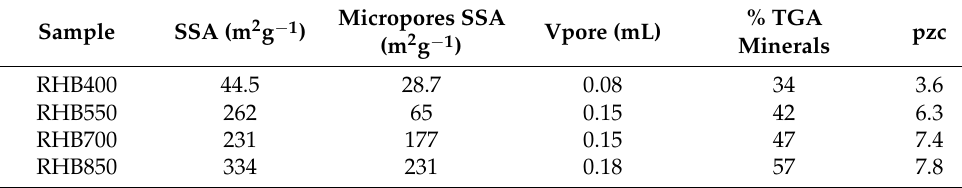
Table 2. Physicochemical characteristics of the biochars studied.